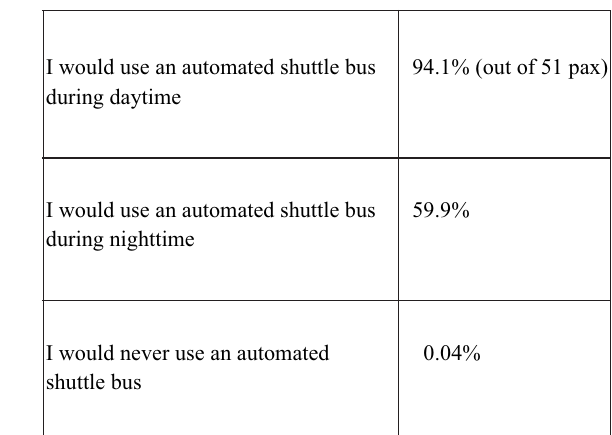
Table 2. Pedestrian feedback on the usage intention